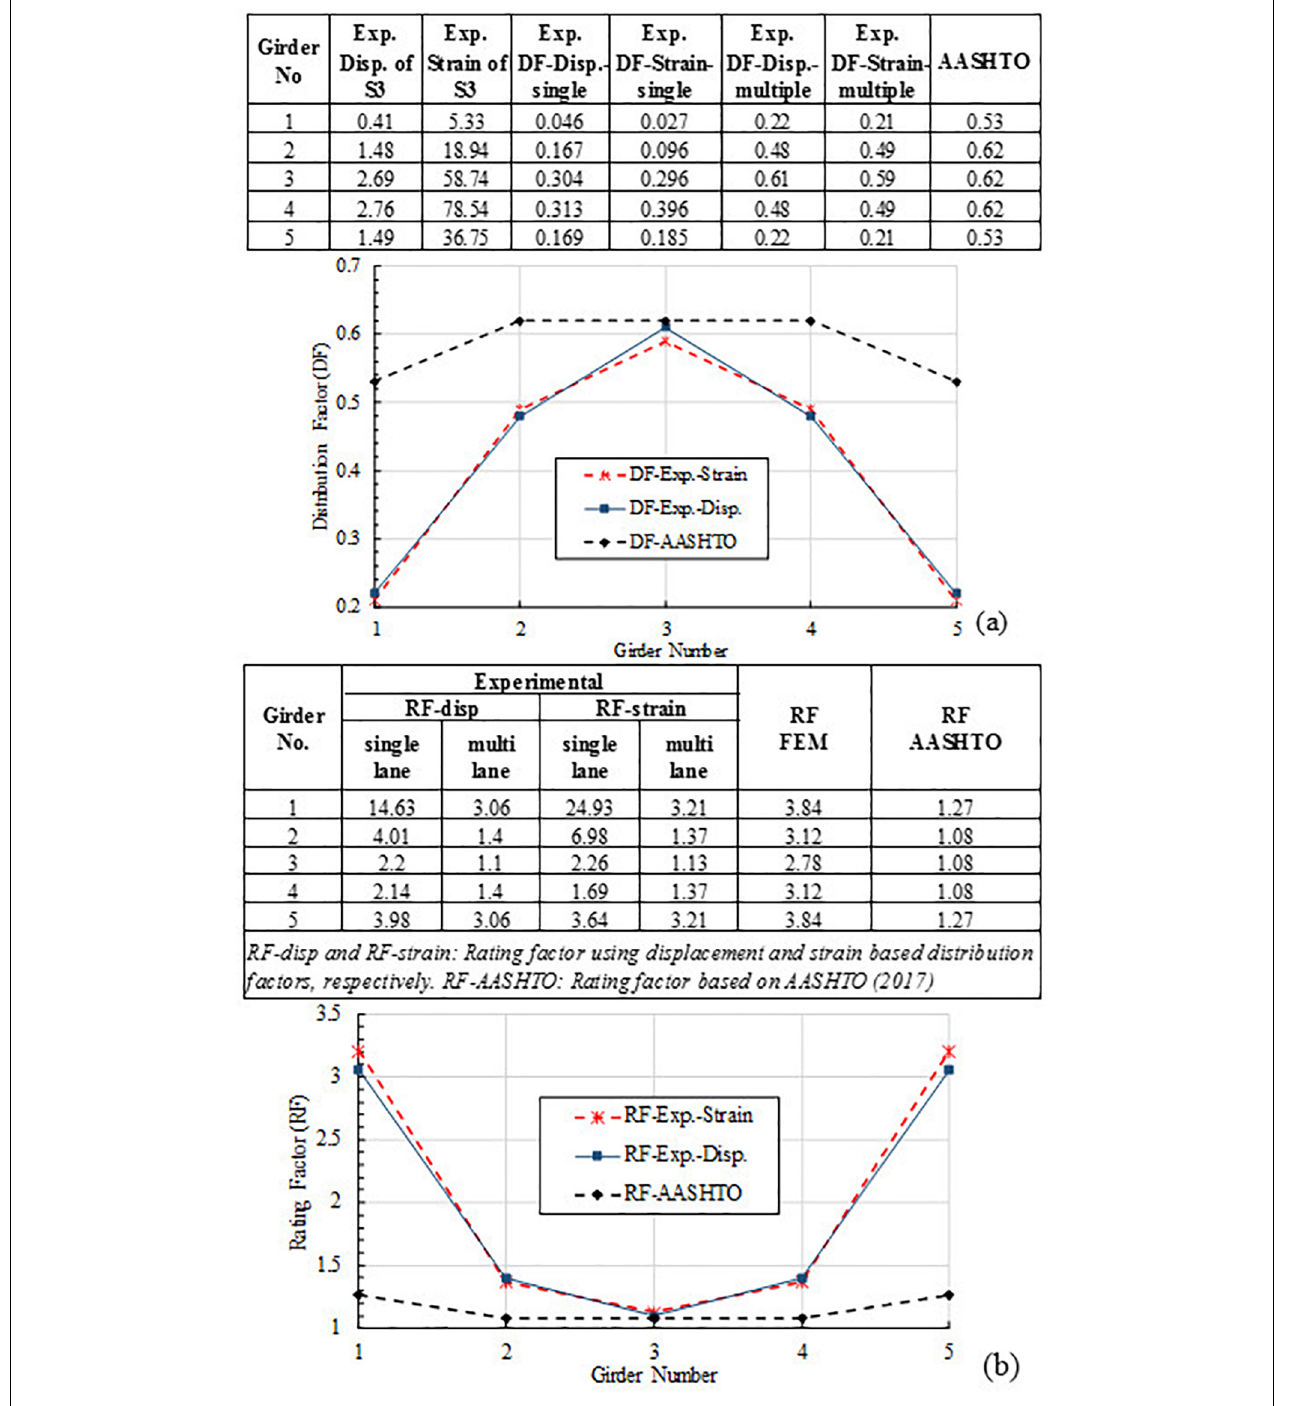
FIGURE 8 | Comparison (A) DF (B) RF